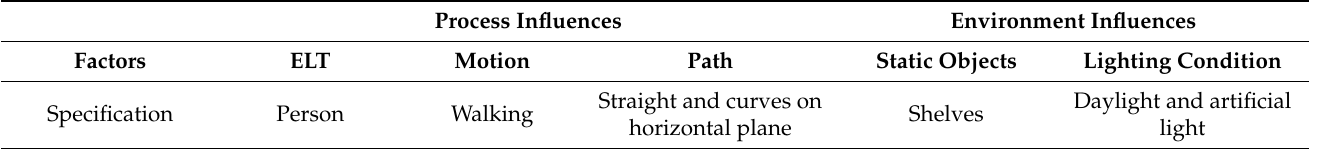
Table 2. Exemplary application-dependent scenario for the application of customer tracking in a supermarket. Camera and UWB ILS are considered as localization